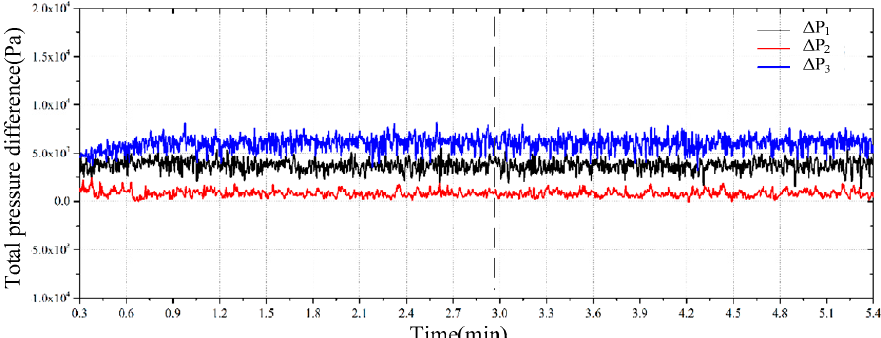
Figure 14. Variations in the total pressure differences (case 2).